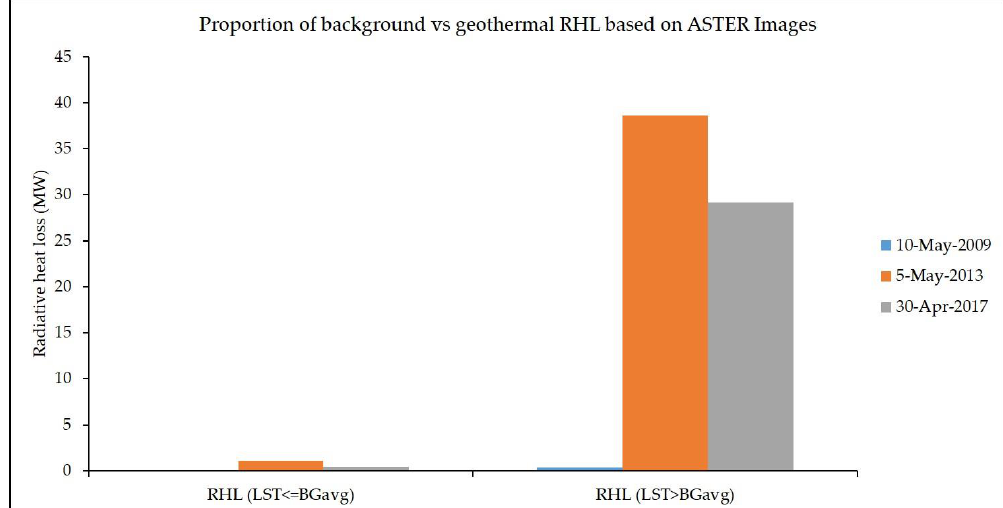
Figure 8. Plot shows the RHL contributed by the pixels with LST < or = background vs. LST < background, of the study area from 2009 to 2017. RHL—radiative heat loss; LST—land surface temperature; BGavg—background LST (average); BGmin—background LST (min); BGmax—background LST (max).